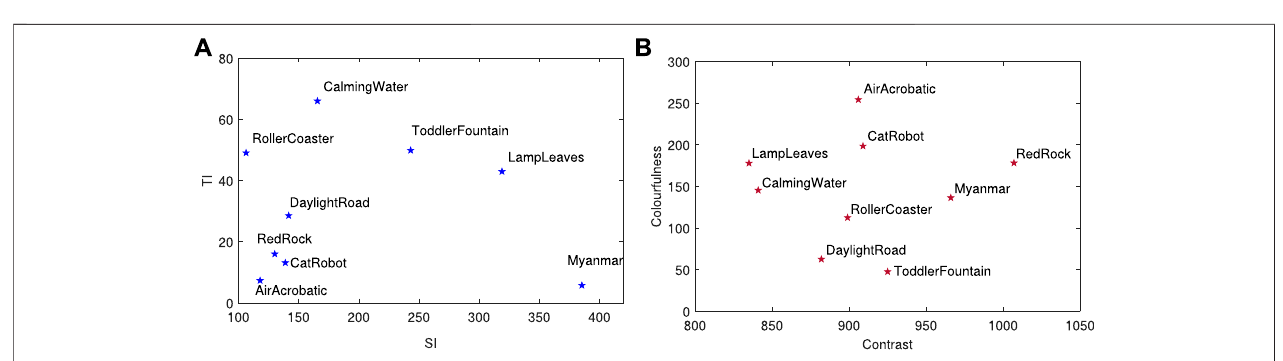
FIGURE 2 | Scatter plots of low level content characteristics: for the selected source sequences: (A) SI vs. TI and (B) CF vs. Contrast.